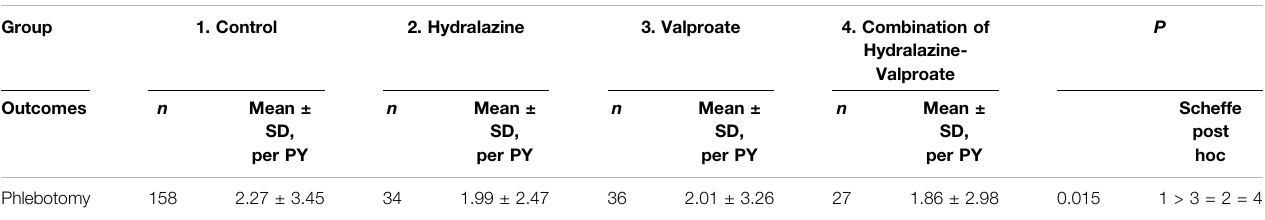
TABLE 2 | Frequency of therapeutic phlebotomy in different groups.